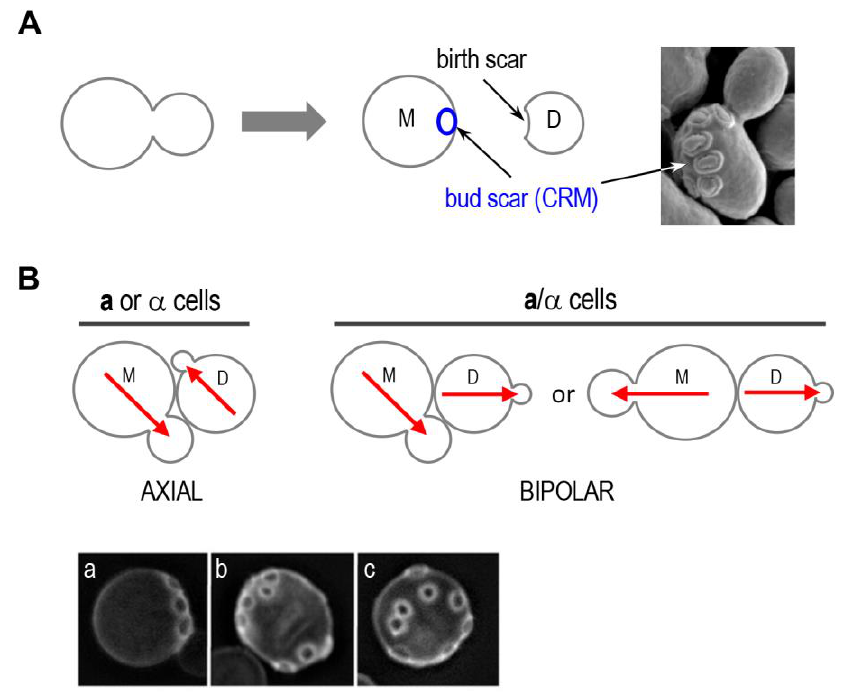
FIGURE 2: Oriented cell divisions of S. cerevisiae . (A) Each cell division leaves a bud scar that marks the site of divi- sion on the mother cell surface and birth scar on daughter cell. Successive divisions produce distinct patterns of bud scars (also called cytokinesis rem- nants: CRMs). Bud scars can be visual- ized by scanning electron microscopy (image on the right) or by staining with the dye Calcofluor (as shown in B ). Electron micrograph was taken from Ref. [44] with permission. (B) Axial and bipolar patterns of bud-site selection in S. cerevisiae . Red arrows denote the axes of cell polarization. Below, the patterns of bud scars on the yeast cell surface resulting from the different modes of budding are visualized after Calcofluor staining: (a) axial pattern; (b) bipolar pattern; and (c) random budding by a mutant (such as rsr1  ). Micrographs were published previously